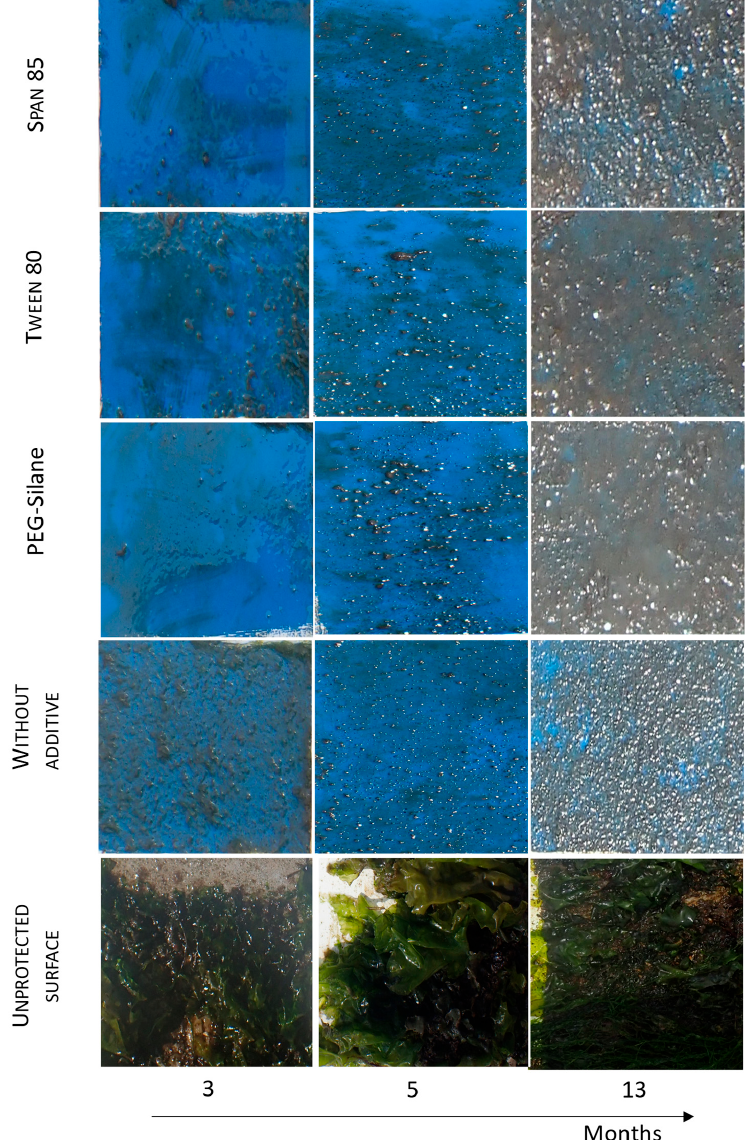
Figure 7. Visual inspection of paints in static condition after 3, 5 and 13 months of immersion in natural seawater.